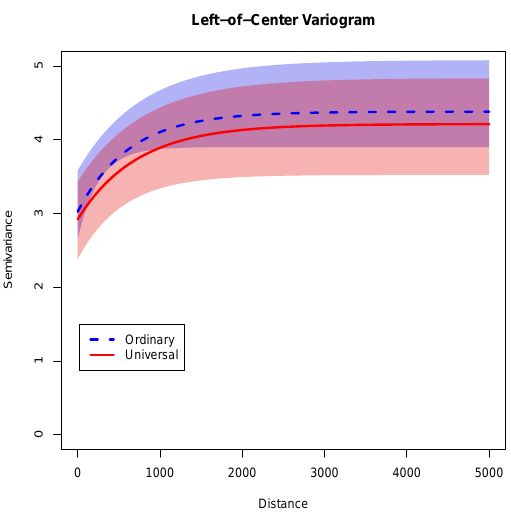
Figure 7. Rival Parametric Semivariograms for Left-of-Center